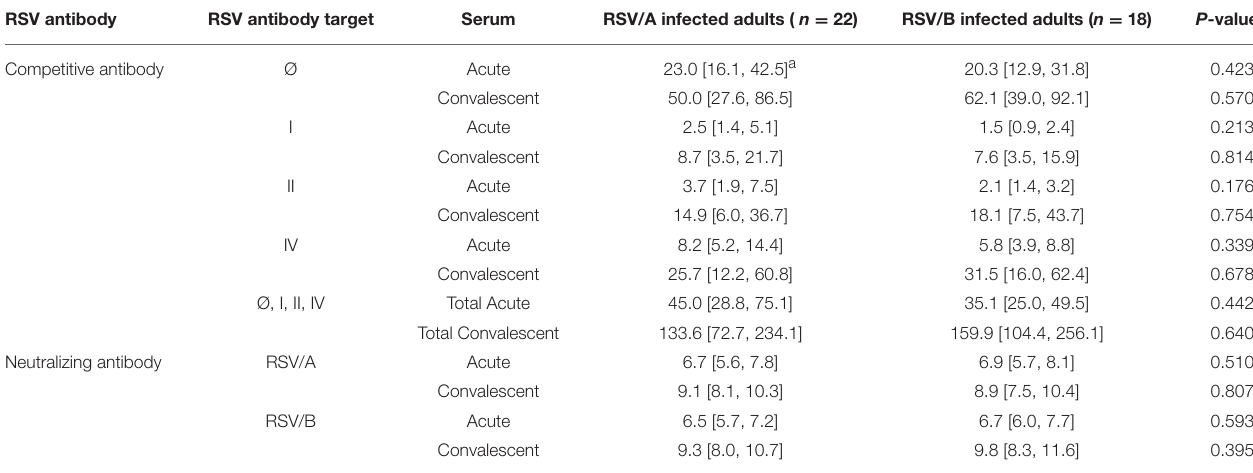
a Geometric mean conc., µ g/mL for competitive antibody and log2 for neutralizing antibody titer [95% Confidence Interval]. b Two-sample t-test for difference in means of antigenic site competitive Ab conc. (log2 µ g/mL) or neutralizing antibody titer (log2) between RSV/A and RSV/B.